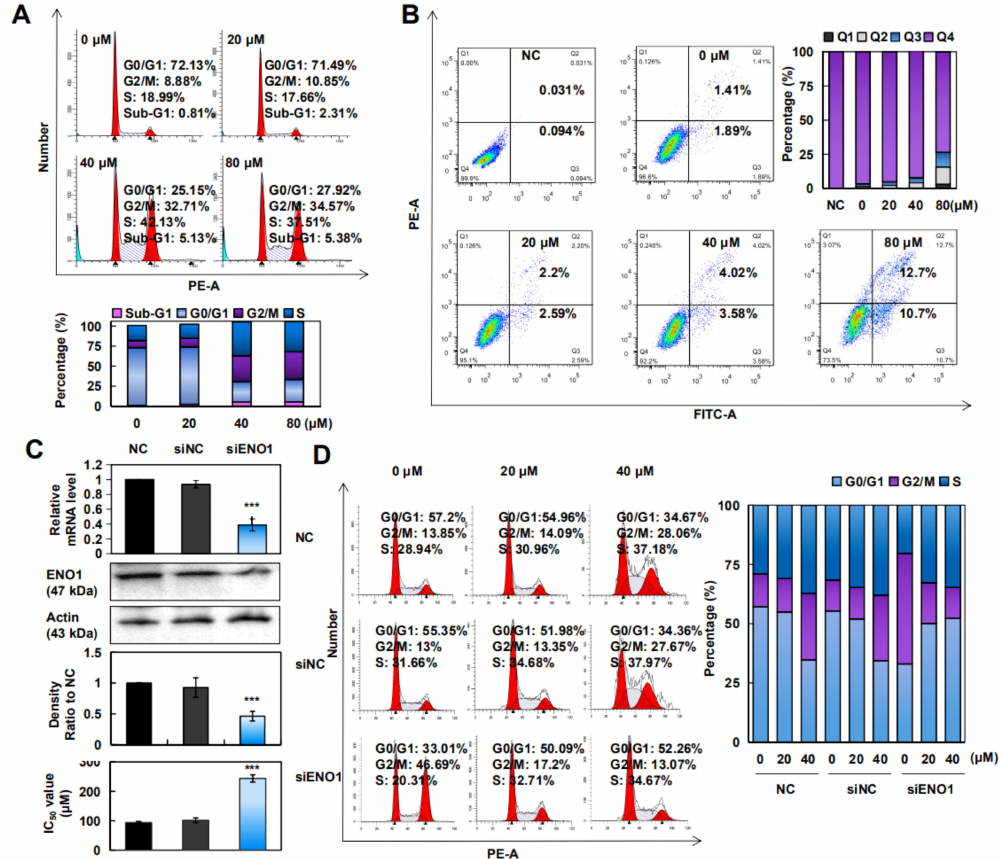
Figure 4. CA arrested the cell cycle, induced apoptosis, and inhibited ENO1 function. ( A ) Cells were treated with 0, 20, 40, or 80 µ M CA for 24 h, after which the cells were collected and stained. The DNA content of the cells was determined with a flow cytometry system. Histograms show the percentage of cells in Sub-G1, G0 / G1, G2 / M, and S phase. ( B ) Cells were treated with 0, 20, 40, or 80 µ M CA for 24 h. A flow cytometric analysis of CA-induced apoptosis in A375 cells was done by double-staining with Annexin V-FITC / PI. Histograms show the percentage of di ff erent regions; “Q2” and “Q3” represent late and early apoptosis, respectively. ( C ) A375 cells were transfected with siENO1 for 48 h, and the relative mRNA level of ENO1 was assayed by qRT-PCR; additionally, the expression of ENO1 in cells was assayed by Western blotting. Histograms show the intensity of the ENO1 protein bands. Finally, cell viability is presented as the IC 50 values ( n = 3). *** p < 0.001 versus “0 µ M” group. ( D ) A375 cells were transfected with siENO1 for 48 h, and then cells were treated with 0, 20, or 40 µ M CA for 24 h. Cells were then collected and determined via flow cytometry system. Histograms show the percentage of cells in G0 / G1, G2 / M, and S phase after treatment with CA. “NC” group stands for normal cultured cells without CA and interference fragment; “siNC” group was used as a negative